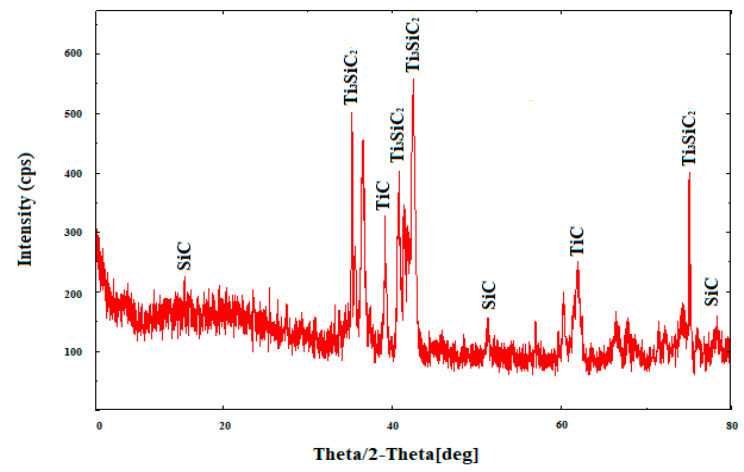
Figure 11. XRD Peaks of Ti-6Al-4V-SiC(15 Wt.%) processed under aging temperature (1150 ◦ C), aging time (four hours), heating rate (5 ◦ C/min), and cooling rate (5 ◦ C/min). The second order model (Equation (12)) which has been generated using response surface methodology for electrical conductivity can be expressed as a “function of pro- cessing parameters” such as aging temperature ( ◦ C), aging time (h), heating rate ( ◦ C/min) and cooling rate ( ◦ C/min) as shown in Equation (6) from the coefficients of regression estimated (Table 10).